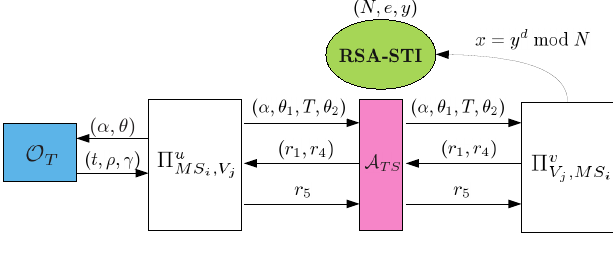
Figure 10. The model of the proof of Ticket Swindling